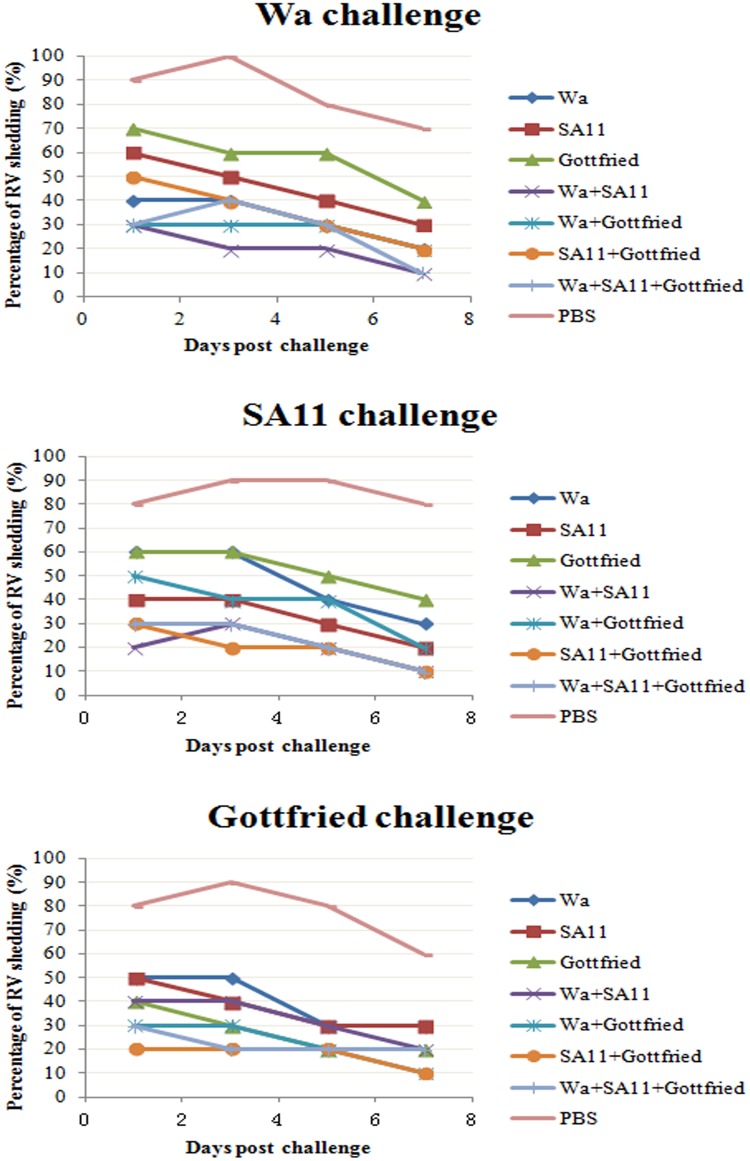
Percentage of RV fecal shedding in suckling mice after RV strains challenge.Suckling mice have required passive immunity from their mother mice. Fecal samples were collected from suckling mice, processed and RV-antigen detected by ELISA test after RV strains challenge. Virus infection rates were expressed as percentage of RV shedding.